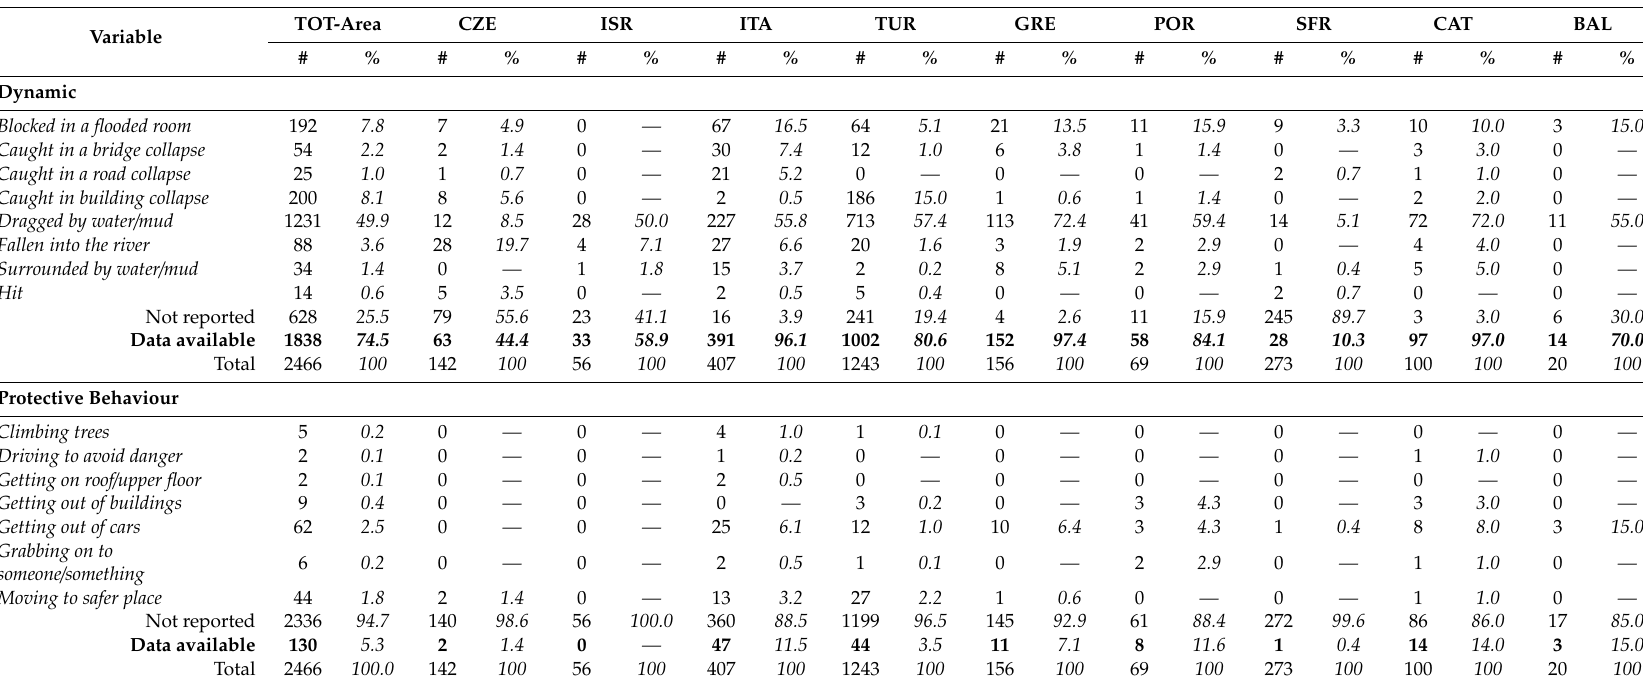
Table A4. EUFF Database: Dynamic and Protective Behavior of fatalities per TOT-A, and per each SA (#: Number; %: Percentage). Data available are in bold and percentage in